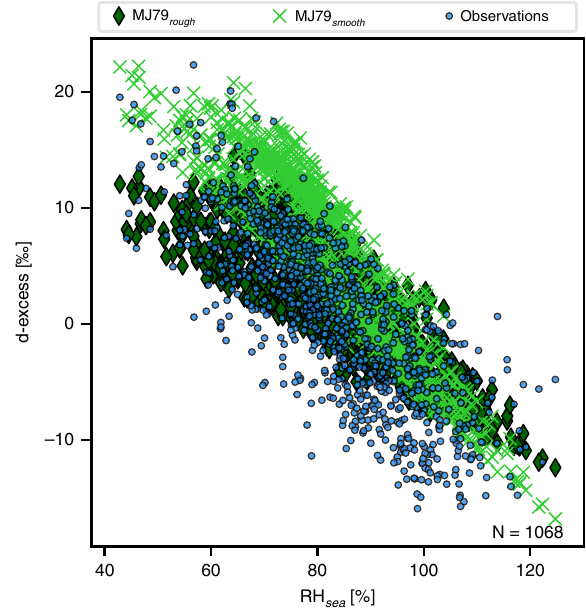
Fig. 4 Sensitivity of the deuterium excess to RH sea values in observed vapour and in MJ79 model calculations with respect to kinetic fractionation parameterisation. Observations (light blue dots) are compared with results of the MJ79 model calculations using either the kinetic fractionation coef fi cients of a smooth wind regime (MJ79 smooth calculation, light green crosses) or of a rough wind regime (MJ79 rough calculation, dark green diamonds). Data for the period 29 June 2015 to 30 June 2017 over an open ocean only, at 6-h temporal resolution are